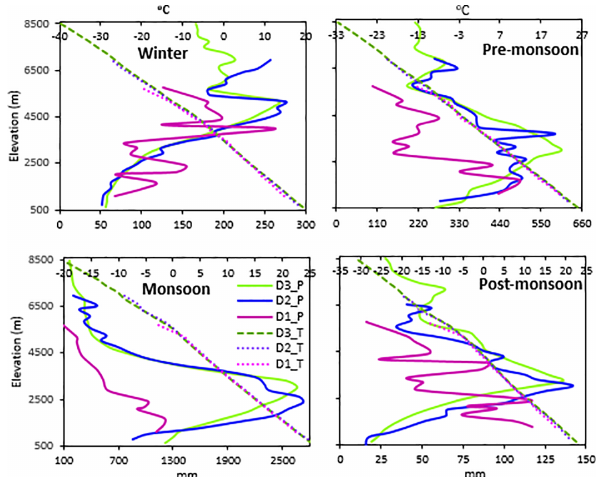
Figure 14. Altitudinal variation in precipitation and temperature at three WRF resolutions for all four seasons (over D3 area region only); the abbreviation are D1, D2, and D3 for the three domains, with P (precipitation) and T